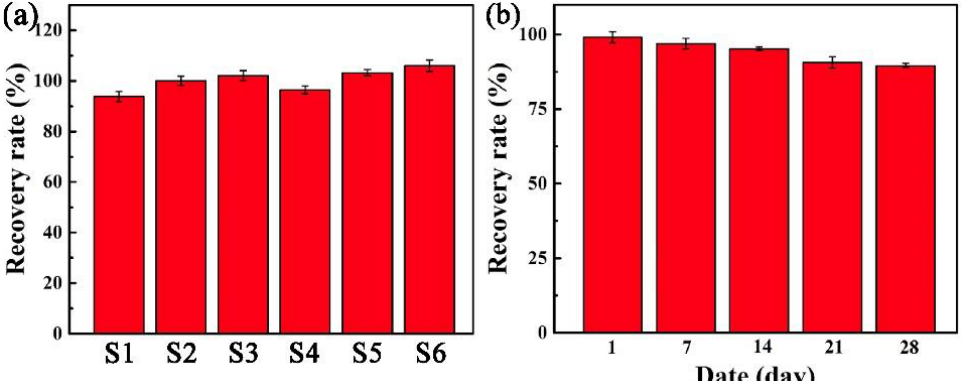
Figure 5. ( a ) Reproducibility of six electrode samples (S1–S6). ( b ) Stability of an as-prepared electrode. Error bars shown were obtained from three independent measurements.